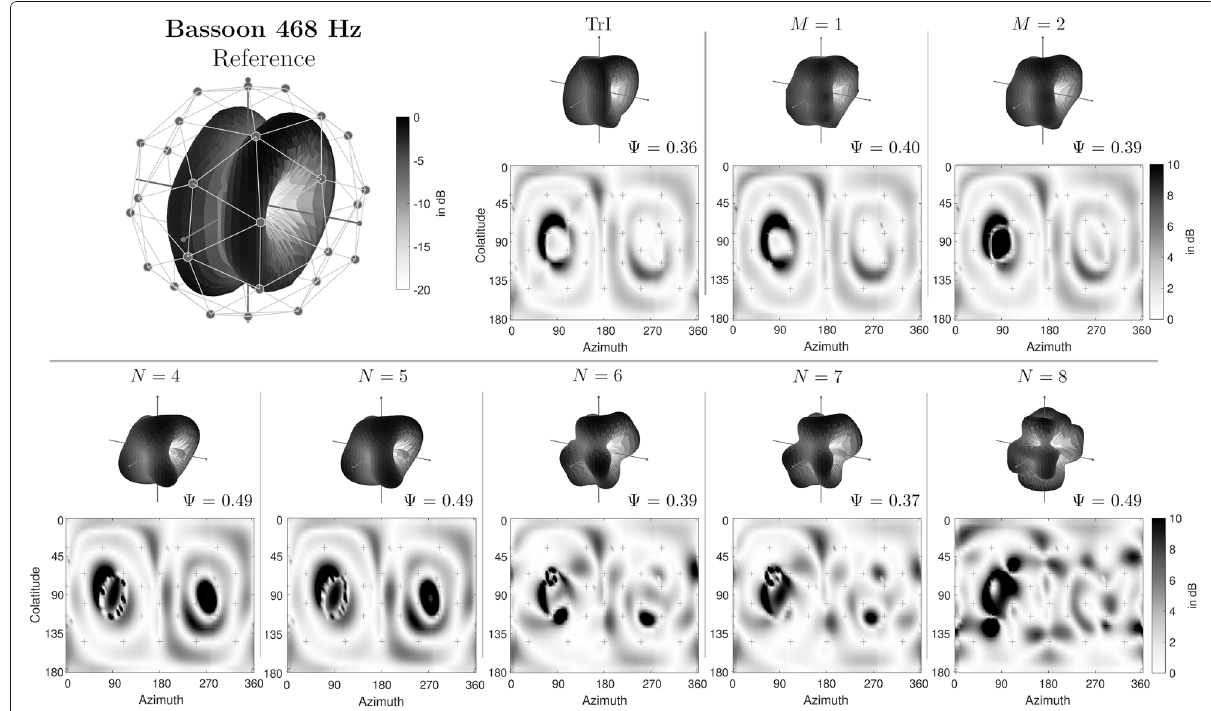
Fig. 3 The high-resolution reference of the bassoon directivety for the second overtone at f 2 = 468 Hz is shown with the 32 sampling points in the upper left. The triangular interpolation (TrI) and spline interpolation estimate for M = { 1,2 } is shown at the top and the results of the spherical harmonics Interpolation (SH) for N = { 4,5,...,8 } at the bottom. The difference of sound pressure level in dB between reference and interpolation is shown over azimuth and colatitude, the gray crosses indicate the sampling points. The result for the spline interpolation with M = 3 is not included in this figure, but is shown in detail in Fig.